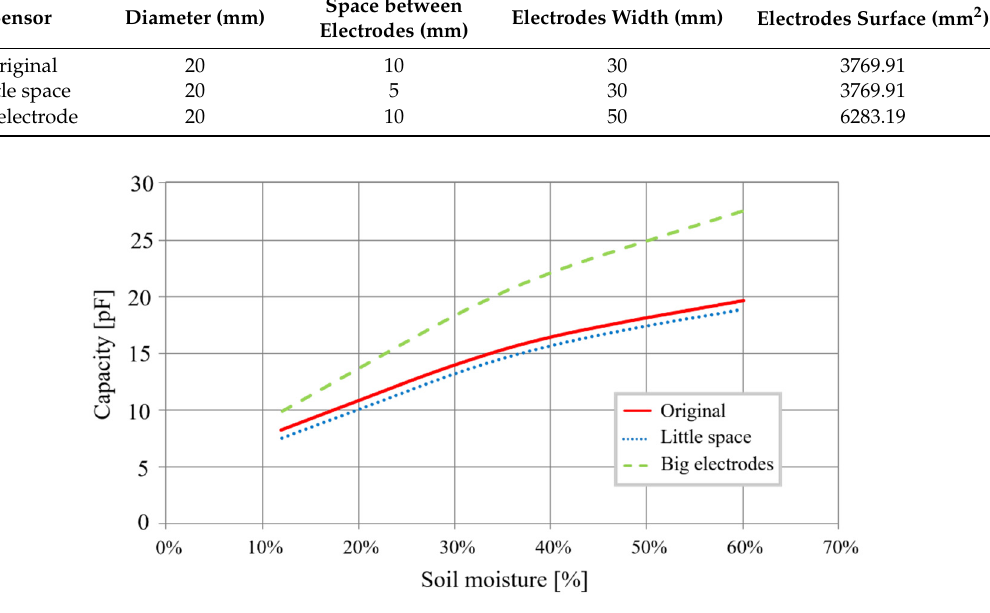
Figure 6. Di ff erent-sized electrodes capacitance as a function of Figure 6. Different-sized electrodes capacitance as a function of moisture. Figure 6. Different-sized electrodes capacitance as a function of moisture.